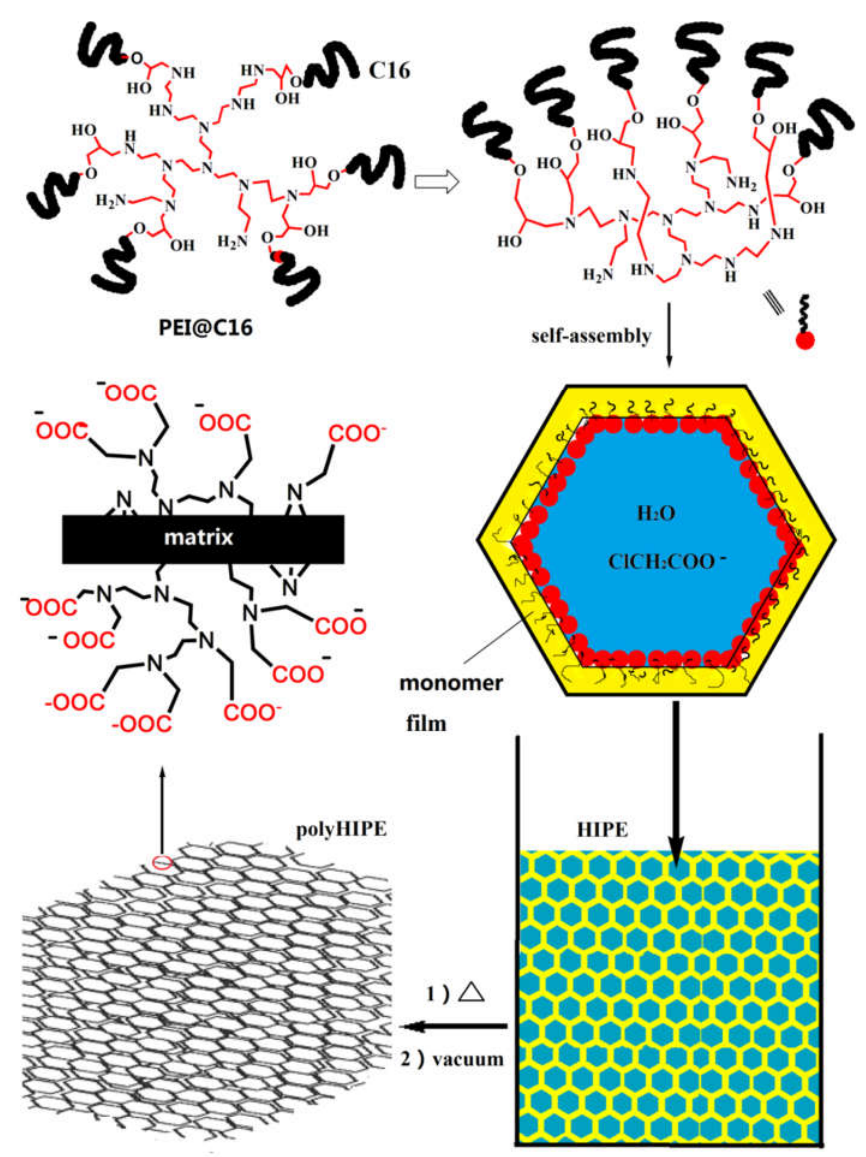
Figure 7. Schematic of PEI-macrosurfactant-mediated synthesis of aminopolycarboxylic acid-dictated polyHIPE. Reproduced with permission from Weng et al. Mater. Chem. Frontiers; published by the Royal Society of Chemistry, 2020 [57].